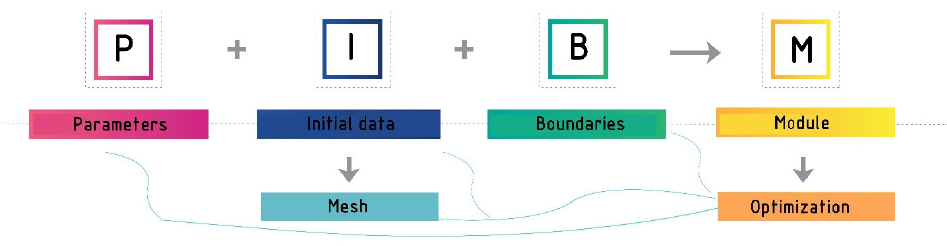
Figure 2. The necessary components of optimization.